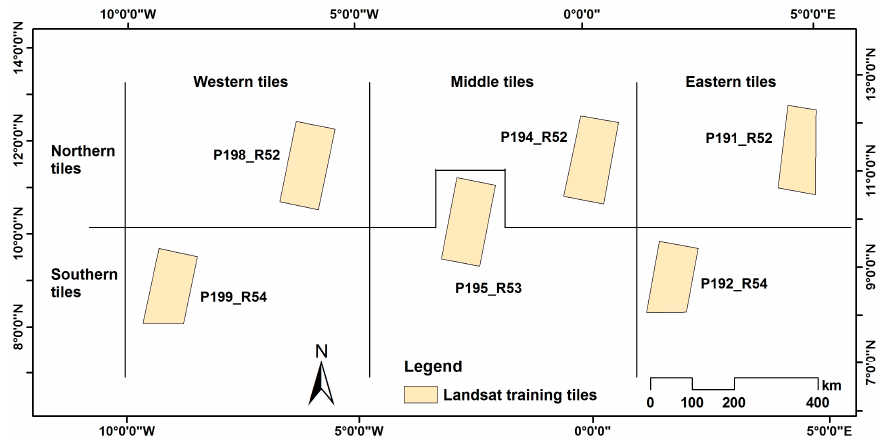
Figure 4. Classification of training tiles in conducting experiments to assess the impact of the number and spatial distribution of training samples on the accuracy of cropland mapping.